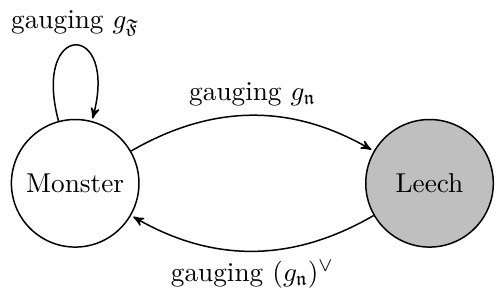
Figure 9. Gauging non-anomalous cyclic subgroups of M in the chiral Monster CFT. Depending on whether the subgroup contains a Fricke element g F or not (generated by a non-Fricke element g n ), the resulting CFT is either the chiral Monster itself or the chiral Leech CFT. In the latter case, gauging the dual symmetry generated by ( g n ) ∨ recovers the chiral Monster CFT